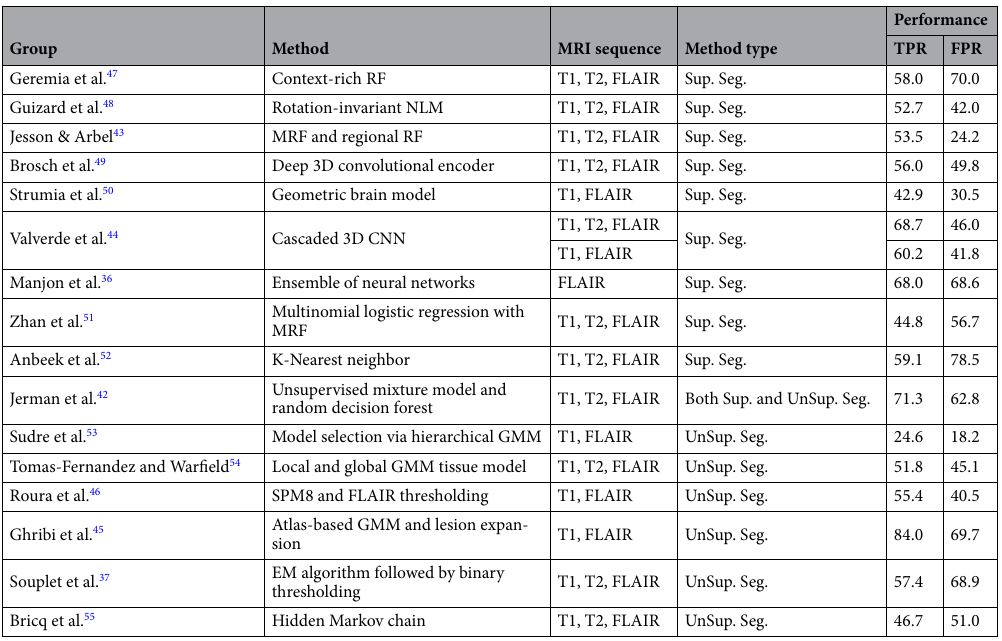
Table 3. Comparison of methods on MICCAI MSLS 2008 test data 44,51